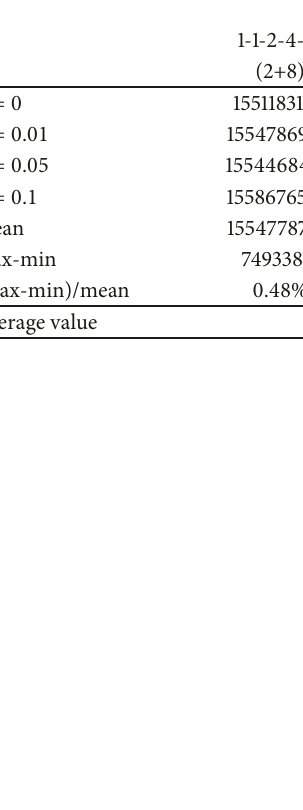
Figure 5: Logistics center and customer location in